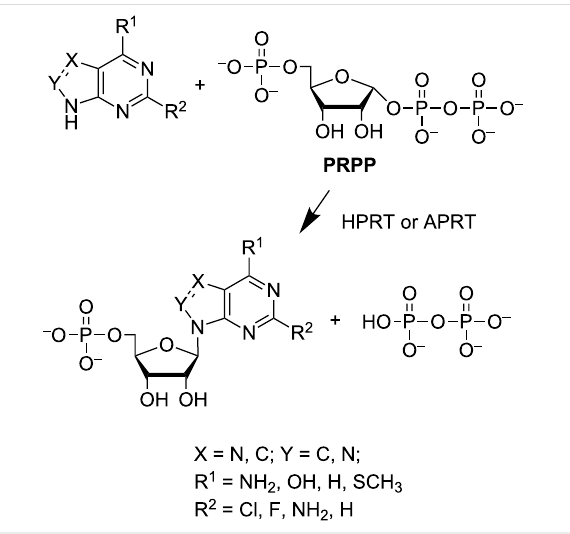
[4,10,11], performing metabolic transformations of substrates.